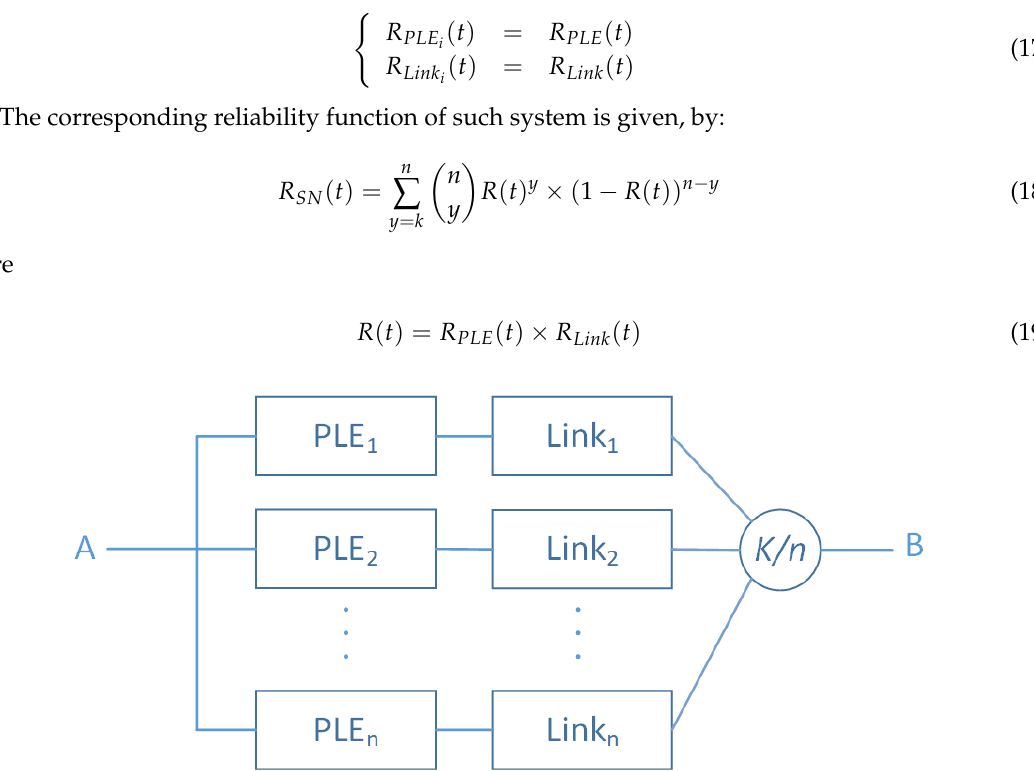
Figure 8. Sensors/Access Network layer entities’ RBD